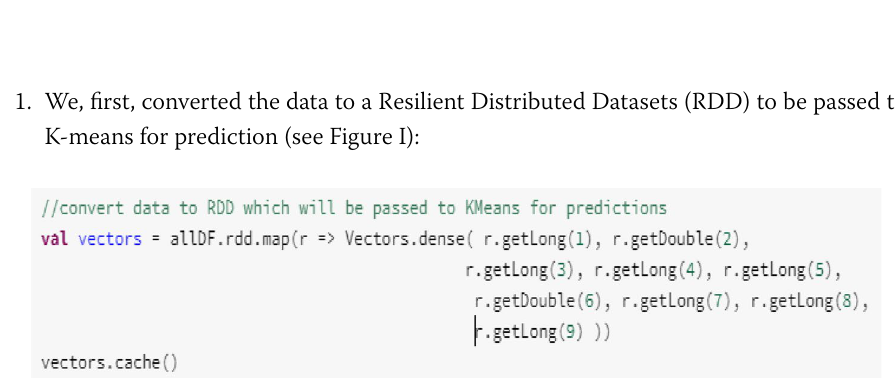
Figure I Creation of K-means vectors Where “ allDF” represents the dataset and “ r.getInteger(1), r.getDouble(2), r.getInteger(3),